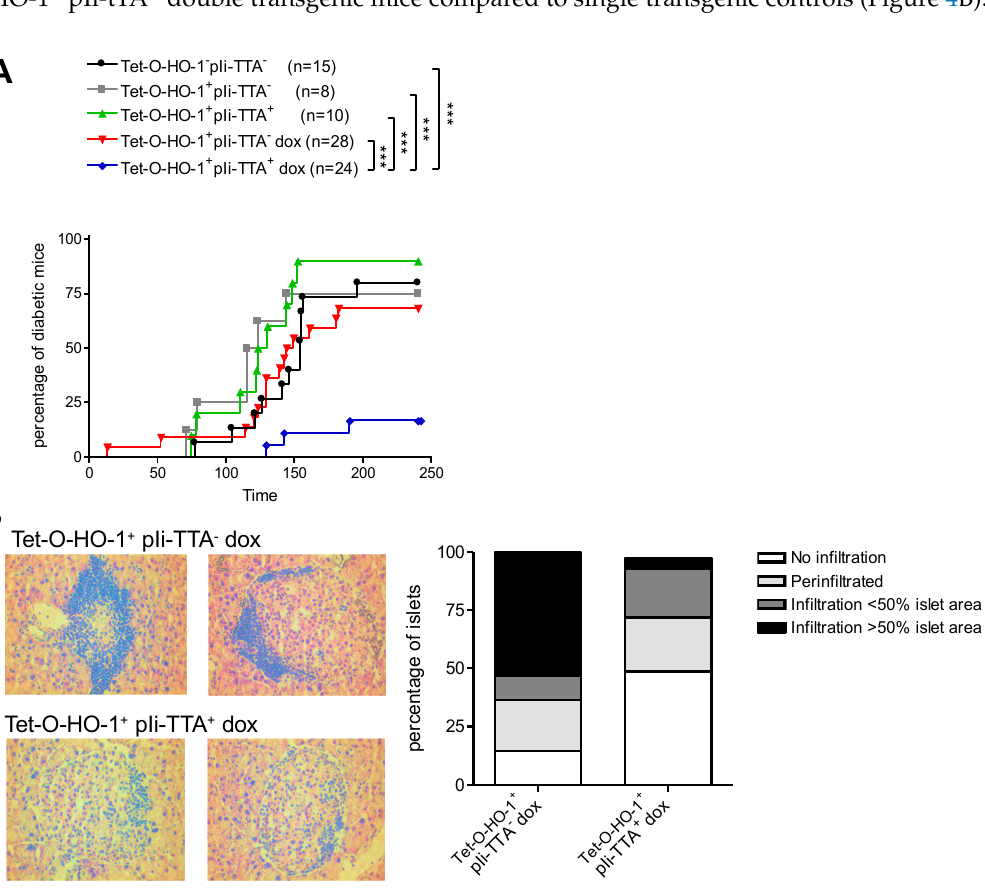
Figure 4. HO-1 induction in DCs decreased diabetes incidence in NOD mice. ( A , B ) Starting at one month of age, non-transgenic, single transgenic Tet-O-HO-1 + pli-tTA − or double transgenic TetO-HO-1 + pIi-tTA + female NOD mice were provided or not with 800 µg/mL of doxycycline (DOX) in their drinking water. ( A ) Cohorts were monitored for the development of diabetes by measurement of glycemia. Mice were considered diabetic when glycemia was over 200 mg/dL for two consecutive days. ( B ) In three-month-old female single transgenic Tet-O-HO-1 + pli-tTA − or double transgenic TetO-HO-1 + pIi-tTA + NOD mice, insulitis was evaluated by hematoxylin and eosin (H&E) staining of